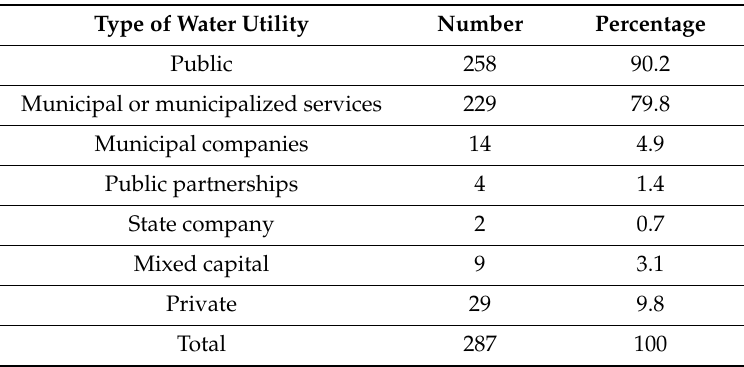
Table 5. Water utilities ‘em baixa’